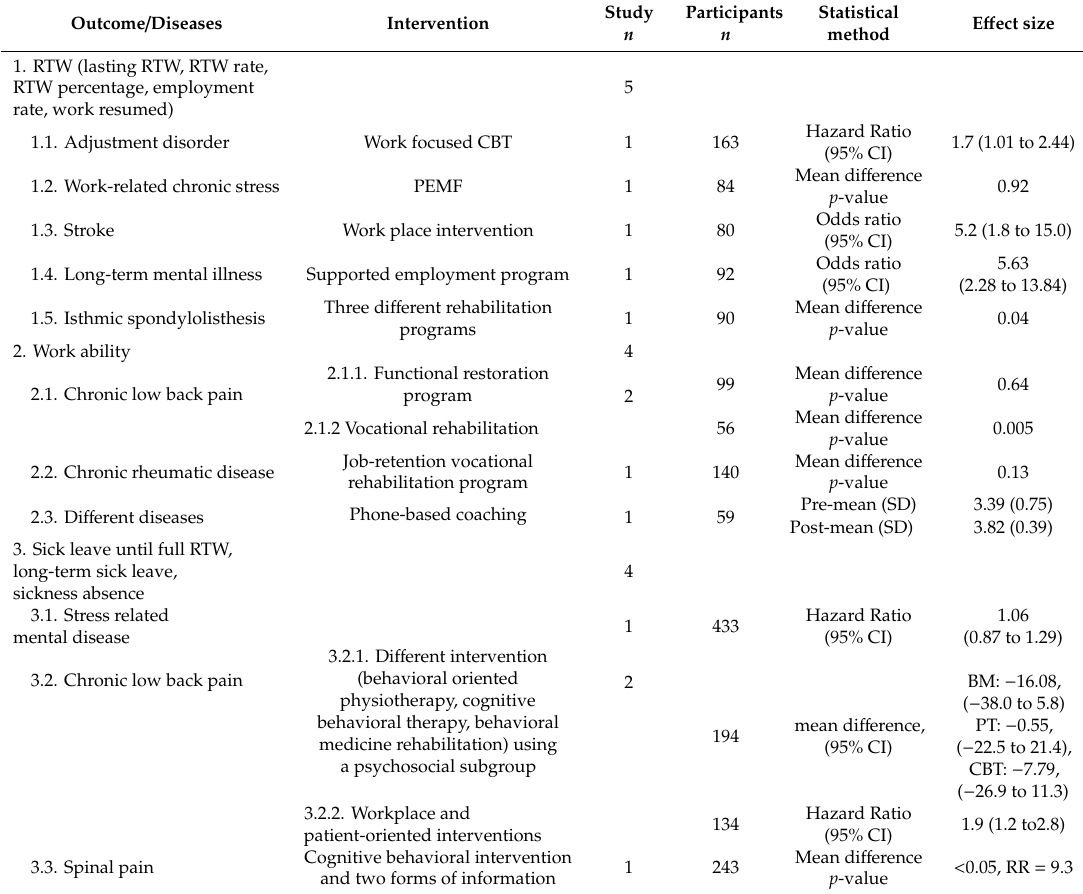
Table 3. Summary of the primary outcome. RTW: return to work; CBT: cognitive-behavioral therapy; PEMF: Pulsed Electro Magnetic